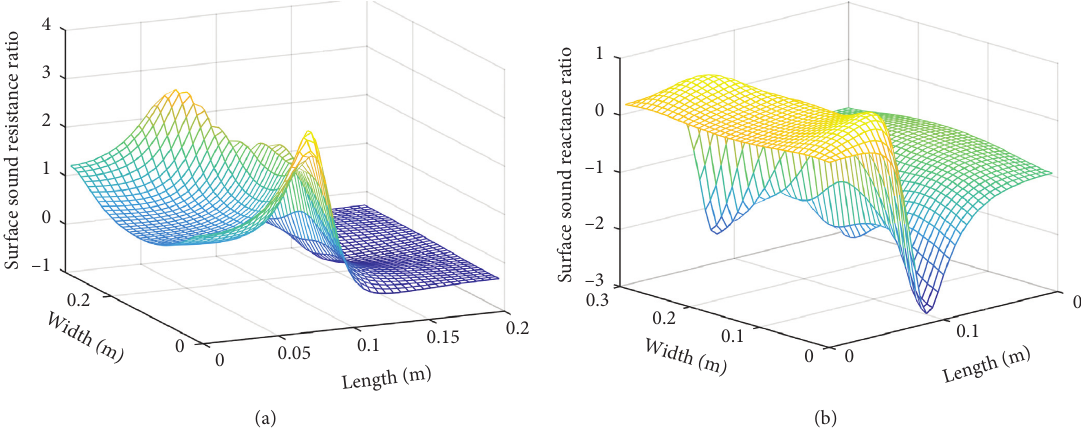
Figure 14: Surface sound impedance of the active MPPA on the resonant frequency of the (2, 1) mode after control: (a) sound resistance ratio and (b) sound reactance